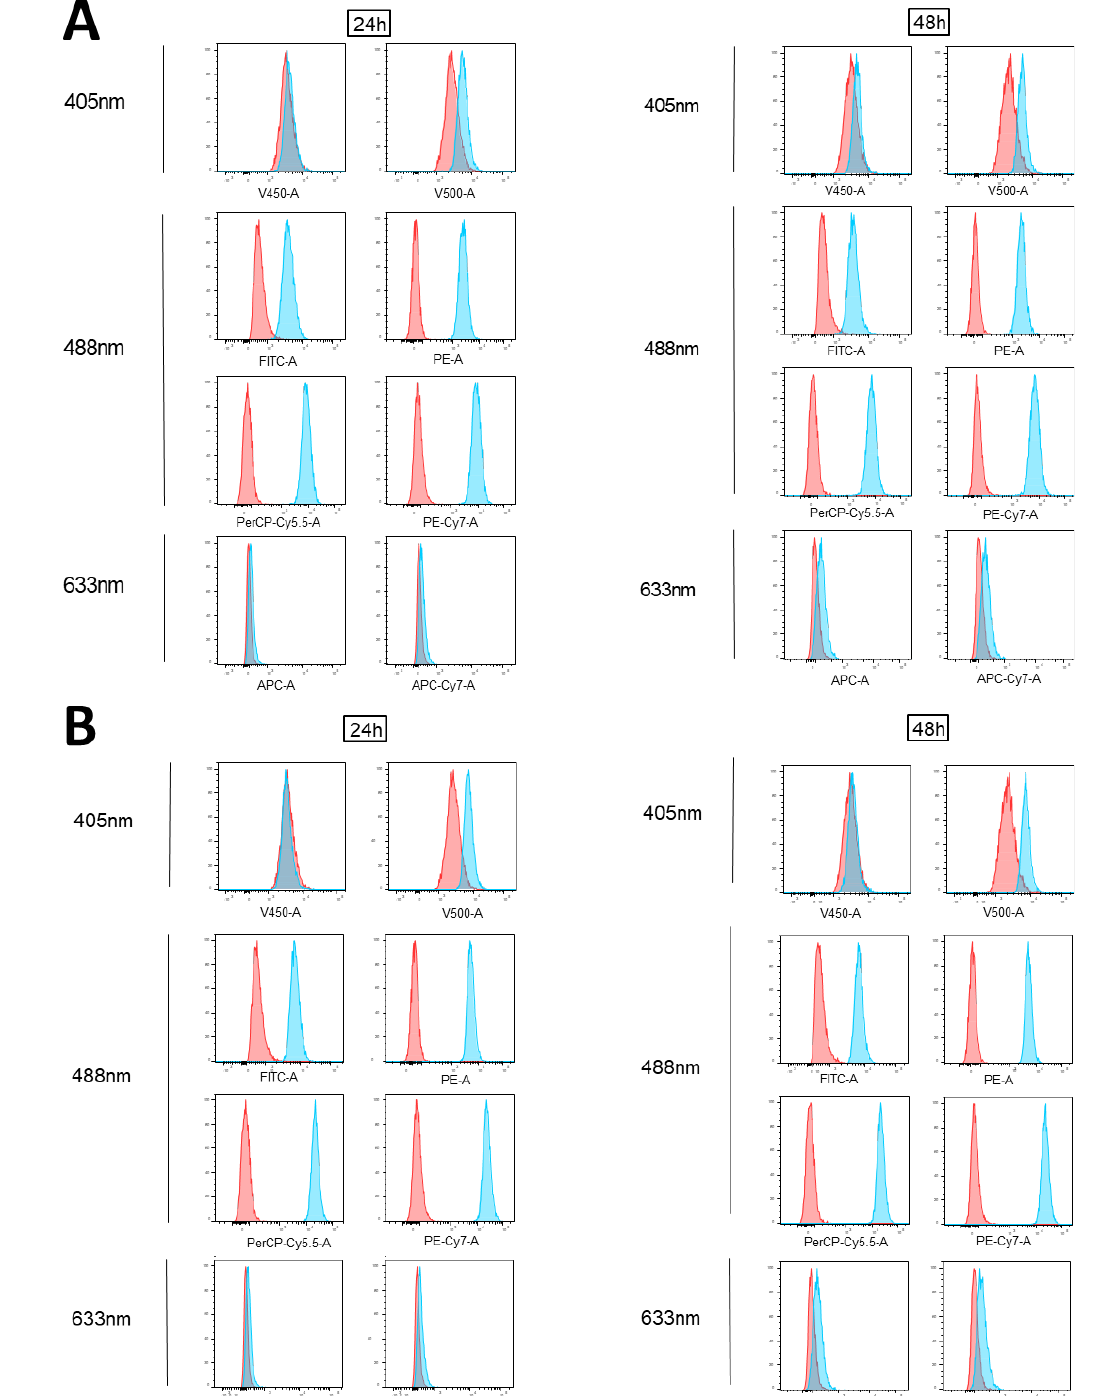
Figure 2. Analysis of epirubicin fluorescence emission via conventional flow cytometry (BD FACSVerse). MDA-MB-231 cells treated for 24 and 48 h with 1 µM ( A ) or 2.5 µM ( B ) epirubicin were acquired using flow cytometry and shown as blue histograms on every channel of a conventional instrument (FACSVerse, BD Biosciences), equipped with three lasers (488 nm, 633 nm, and 405 nm). Overlayed red histograms show the related untreated samples. Histograms are representative of three independent experiments.